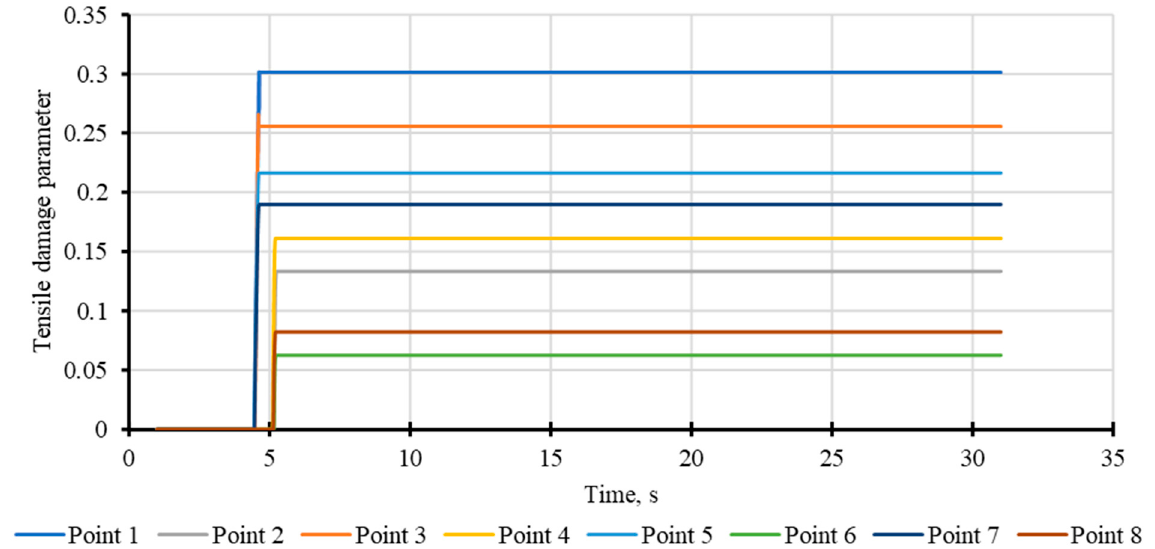
Figure 15. Damage accumulation curves in the tunnel lining material at characteristic points.